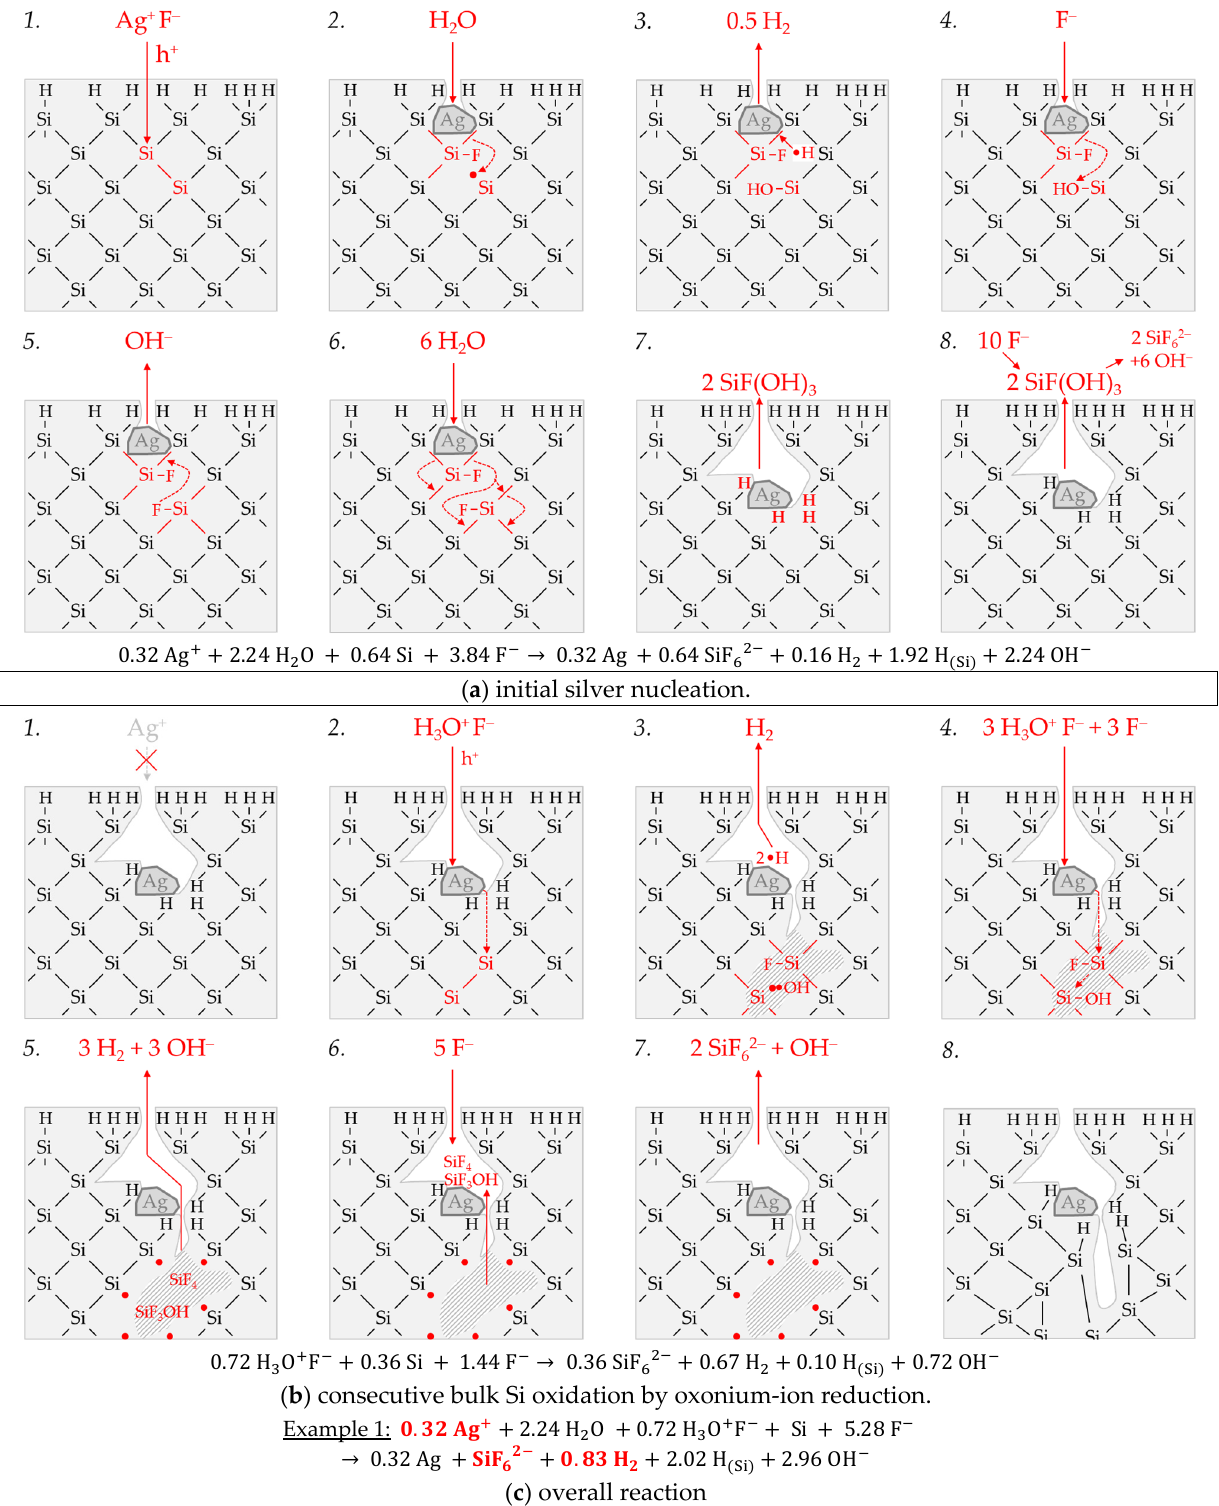
Figure 3. Schematic reaction process and balance, based on example 1 labeled in Figure 2e,f, with a Δ n Ag: Δ n Si : Δ n H 2 ratio of ≈ 0.32:1:0.83 mol:mol:mol ( a ) with eight reaction steps of initial silver nucleation, ( b ) subsequent oxonium-ion reduction and ( c ) the balance of the overall reaction.